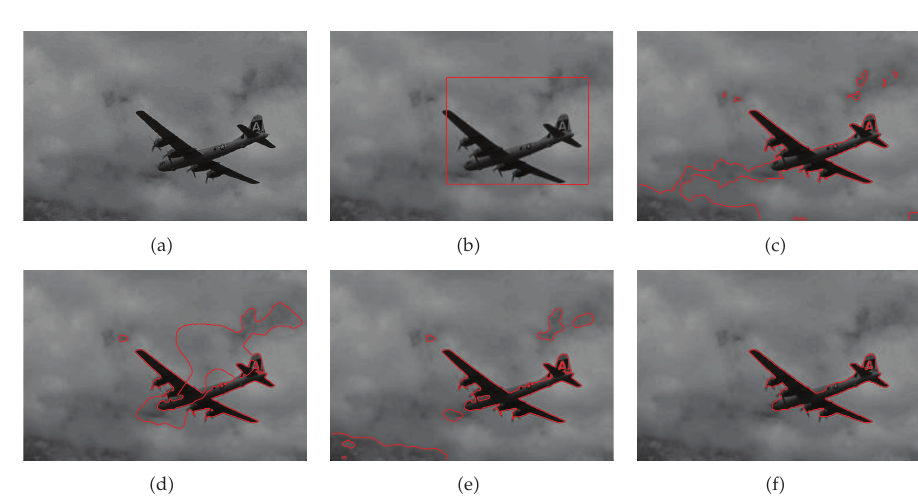
Figure 2: Results of an airplane image with di ff erent models. (cid:6) a (cid:7) The original image. (cid:6) b (cid:7) The initial contour. (cid:6) c (cid:7) The final contour with the CV model. (cid:6) d (cid:7) The final contour with the LBF model. (cid:6) e (cid:7) The final contour with the LGIF model. (cid:6) f (cid:7) The final contour with the proposed model.